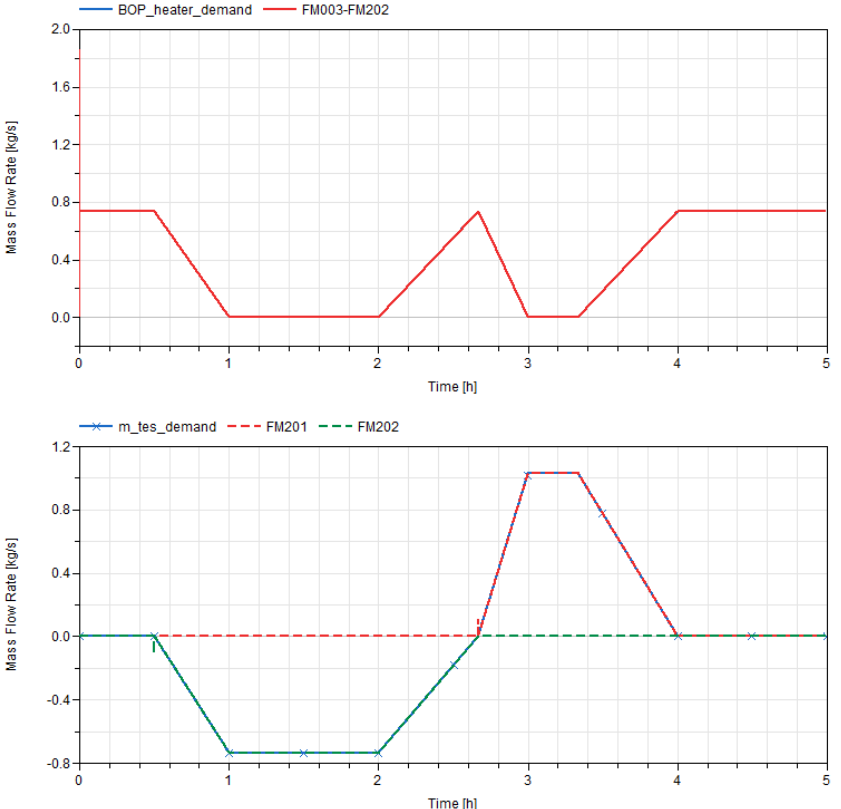
Figure 13. Shakedown Testing: ( Top ) Balance-of-plant mass flow rate. ( Bottom ) Thermal-energy storage mass flow rate vs. sensor reading.